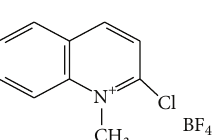
Figure 2: Formulae of 2-chloro-1-methylquinolinium tetrafluorob-